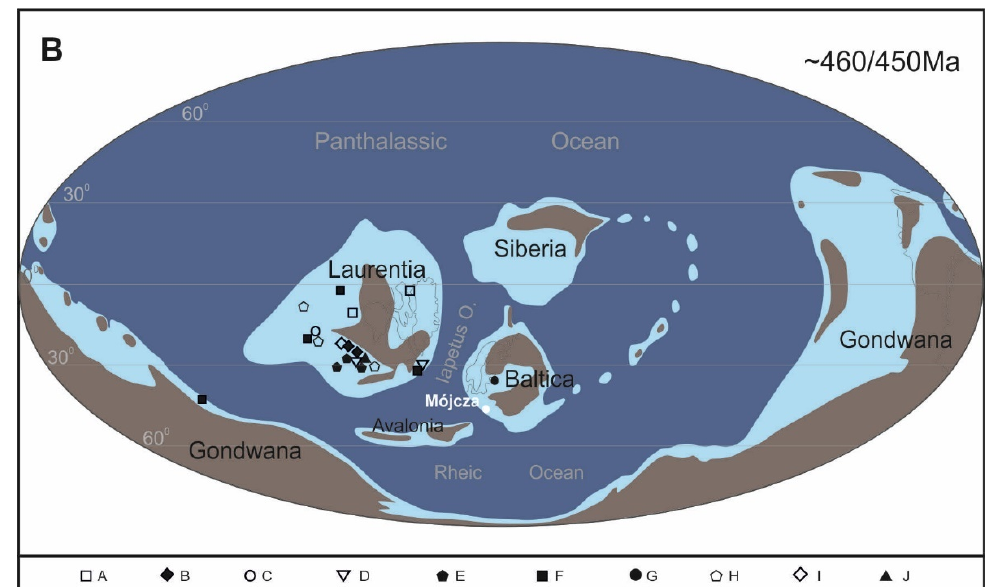
Figure 1. ( A ) Geological map of the western Holy Cross Mountains (without Pleistocene deposits, after Czarnocki [30] and Dadlez et al. [31], modified) and locality of the Mójcza section, EEC—East-European Craton, ŁB—Łysogóry Block, MB—Małopolska Block, BV—Brunovistulia block, BM—Bohemian Massive, TTZ—Teisseyre-Tornquist Tectonic Zone, HCF—Holy Cross Fault, 1—Caledonian front, 2—Variscan front, 3—Alpine front. ( B ) Palaeogeographic locality of the Mójcza section in the late Middle-Late Ordovician (palaeogeography from Scotese [32], modified) and other localities documenting δ 18 O apatite in the same stratigraphic interval (A—Trotter et al. [5]; B—Buggisch et